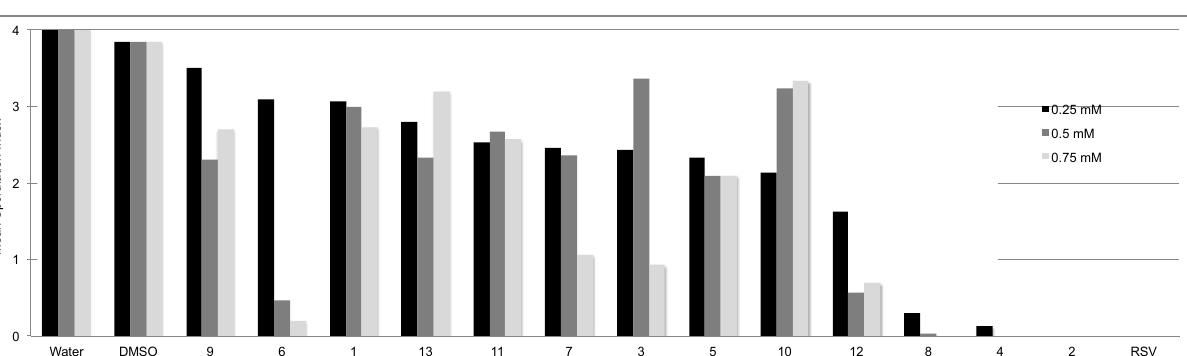
Figure 2. Effect of stilbenes (0.25, 0.5 and 0.75 mM) on P. viticola sporulation . Leaf disks (10/condition) were inoculated with a P. viticola sporangia suspension added by the stilbenes, water or DMSO (2% v/v final concentration) as controls. The index of sporulation was scored at 6 days post-inoculation on a scale of 0 to 4, where 0 = no visible sporulation, 1 = 1% to 25%, 2 = 26% to 50%, 3 = 51% to 75%, and 4 = 76% to 100% of the disk area covered. Values represent the mean index from three independent experiments.